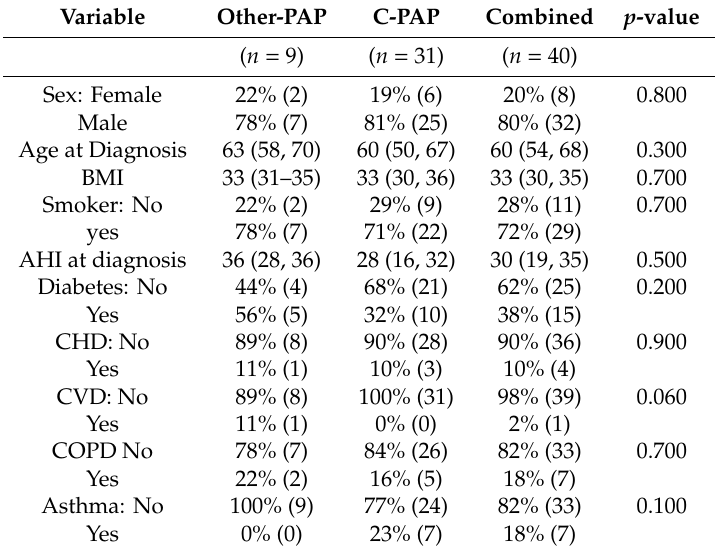
Table 1. Descriptive table on the baseline characteristics accordingly to the intervention group.